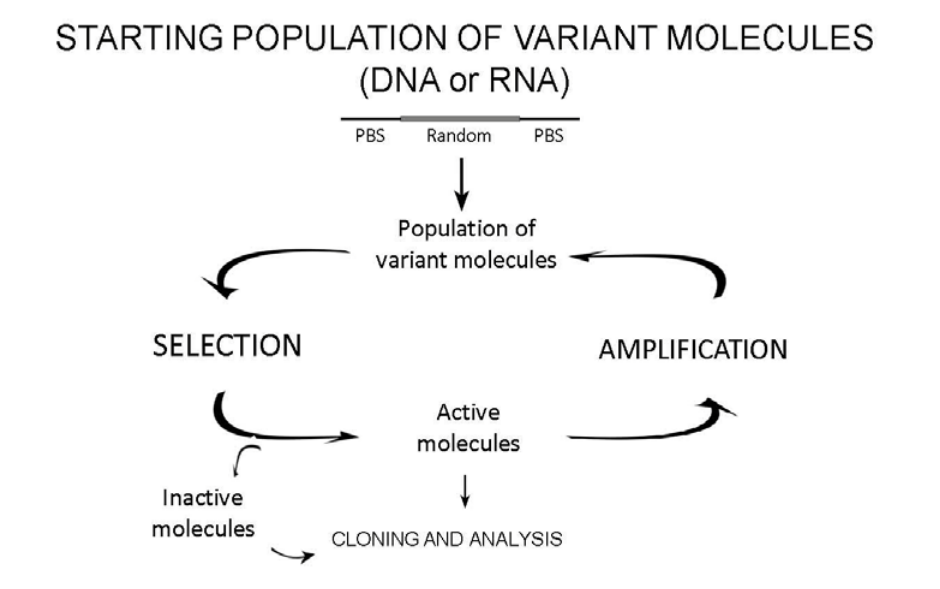
Figure 1. General scheme of in vitro selection procedures. The starting population of variant molecules enters in the selection cycle. Sequence variants are separated into active, those that satisfy selection criteria, and inactive molecules. Active molecules are selectively amplified by PCR resulting in the production of a new pool of molecules that can be the input of a new selection cycle. An additional reverse transcription and in vitro transcription steps are required, before and after PCR, respectively, when the selection is performed on RNA molecules. Alternatively, active and inactive resulting pools can be cloned and